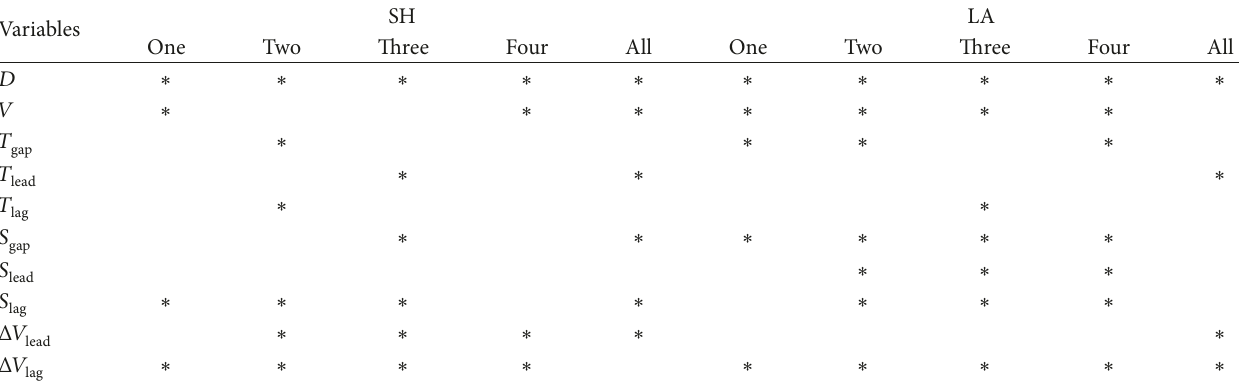
Table 5: Significant variables of logistic regression model.